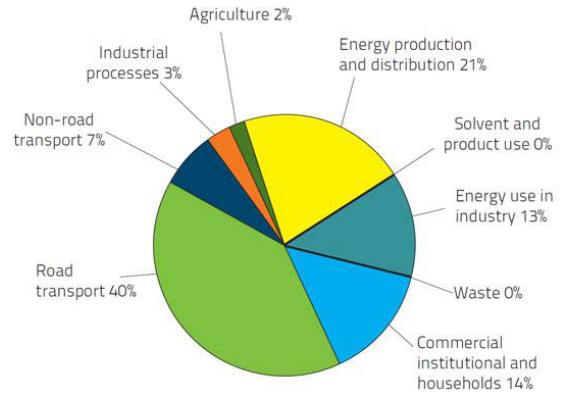
Fig. 3. NO x emissions in the EU during 2011 [5] Similar situation was in USA, when during 2010 road transport and energy production are the prime sources for emission of NO – Fig. 4. x